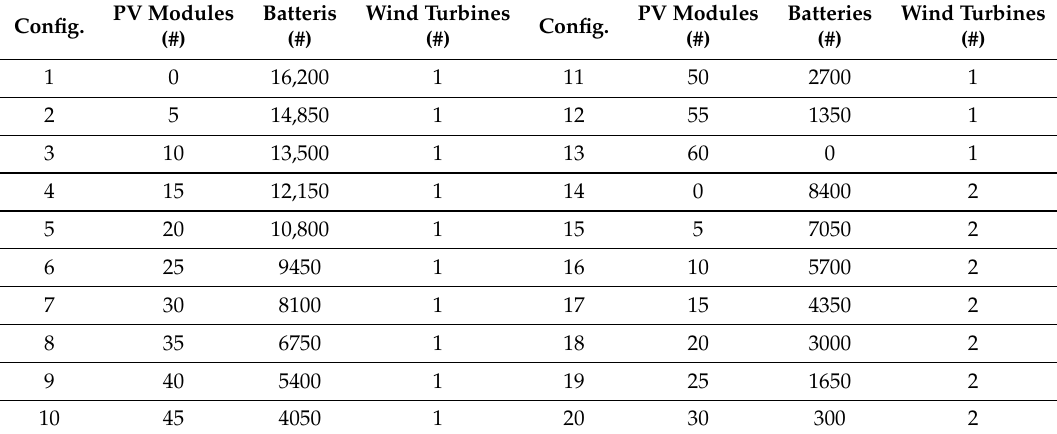
Table 5. Different configurations with fixed initial capital cost in the exploration.